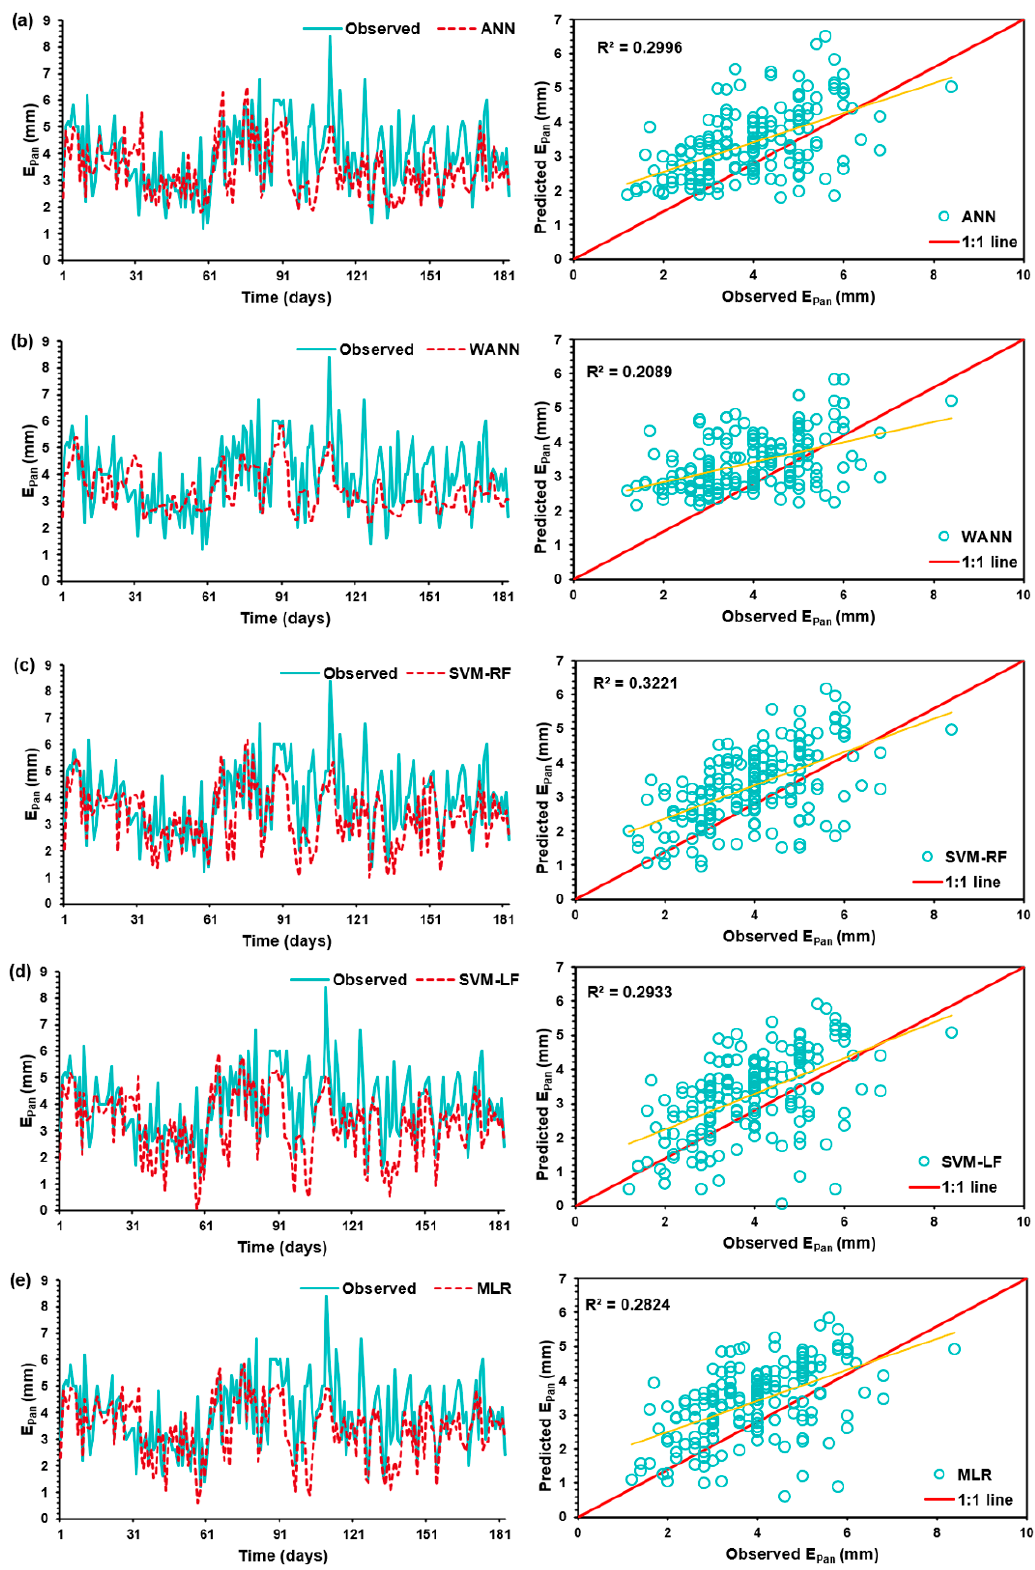
Figure 7. Line and scatter plots between observed and predicted data at Scenario 2 for ( a ) ANN, ( b ) WANN ( c ) SVM-RF, ( d ) SVM-LF, and ( e ) MLR, for the study